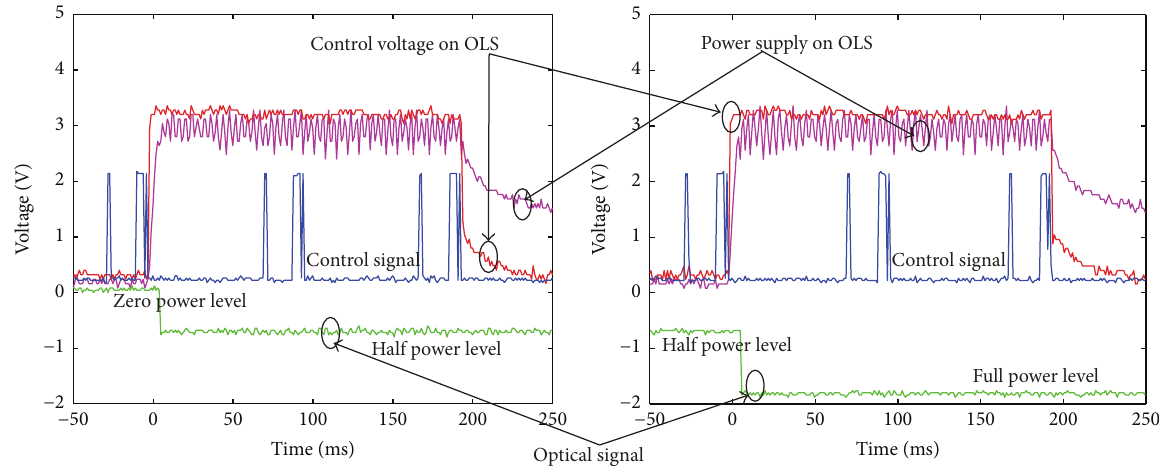
Figure 14: Experimental results of the 1 × 2 × 2 QPAR remote